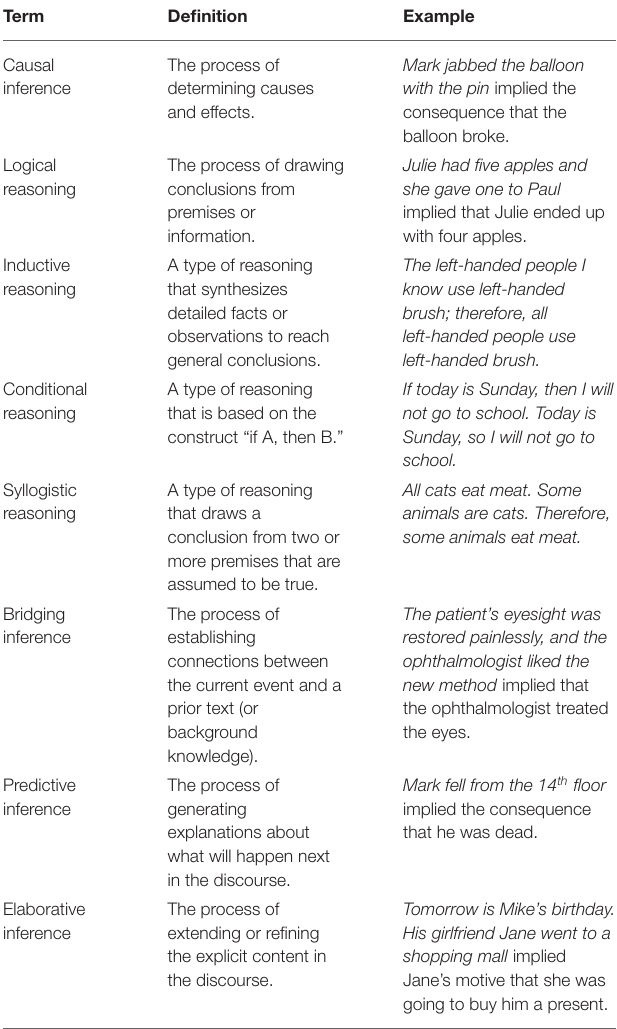
TABLE 1 | Definitions and examples of key